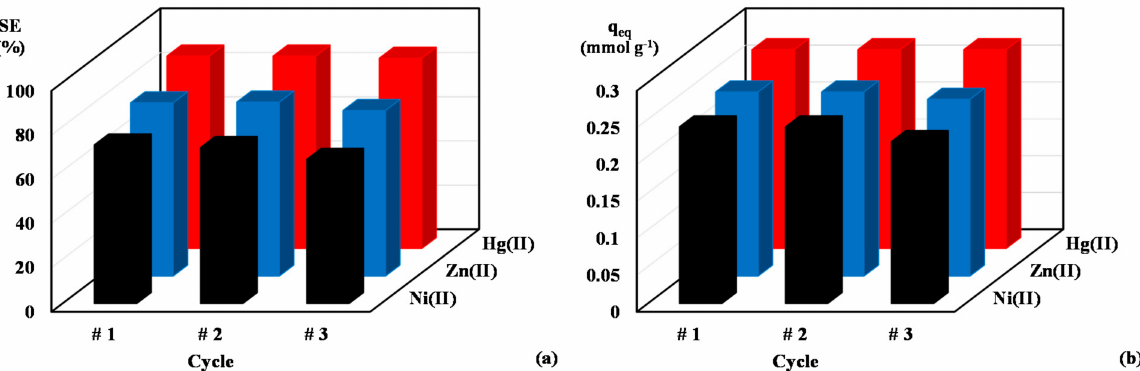
Figure 8. Sorbent recycling for 3 cycles—Sorption efficiency (SE, %) ( a ), and sorption capacity ( b ) (q eq , mmol g − 1 ) (experimental conditions: identical to standard sorption experiments, see Figure